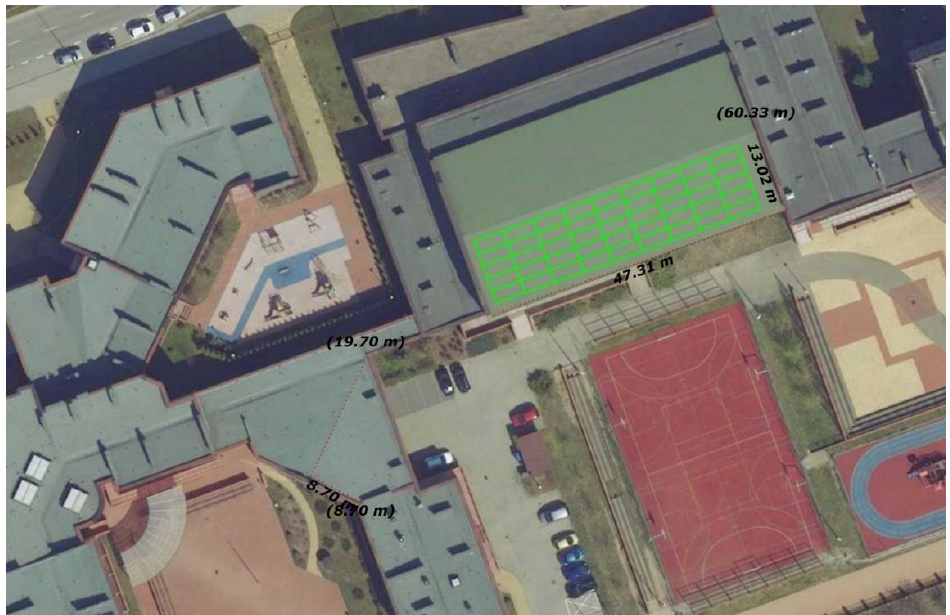
Figure 9. Arrangement of solar collectors on the roof (45 pcs).